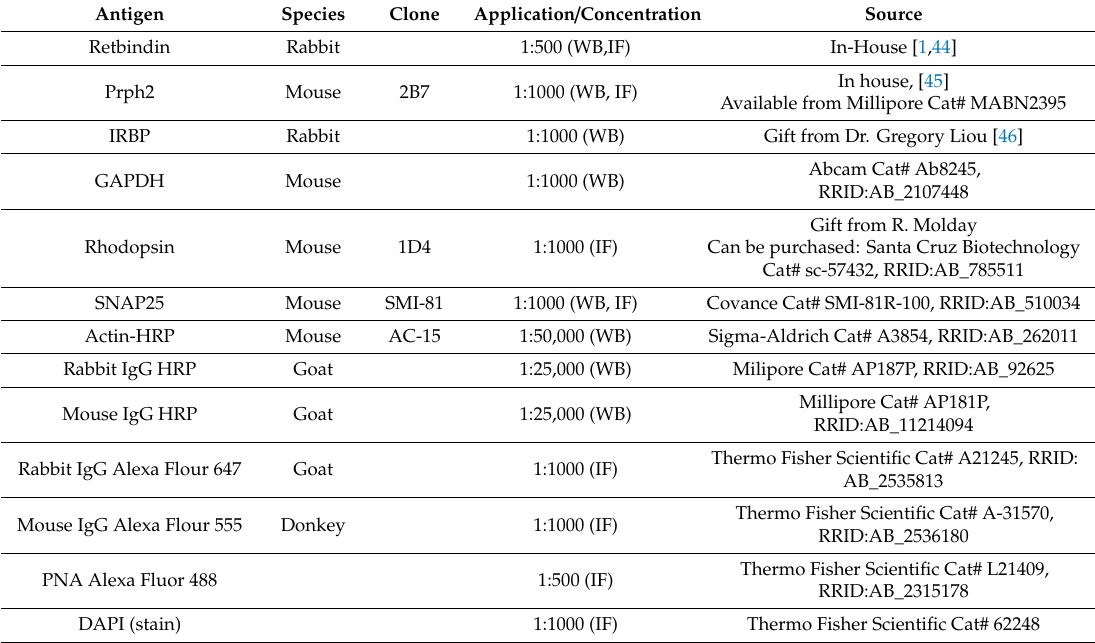
Table 1. Antibodies used. Antibodies and associated parameters are listed. WB: western blot, IF: